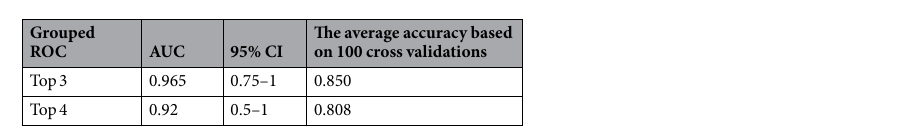
Table 2. AUC of combined metabolites of the top 3 or 4 metabolites from Table 1 based on lowest p-value and highest AUC, as determined by random forests classification modeling. ROC, receiver operator curve; AUC, area under curve; CI, Confidence